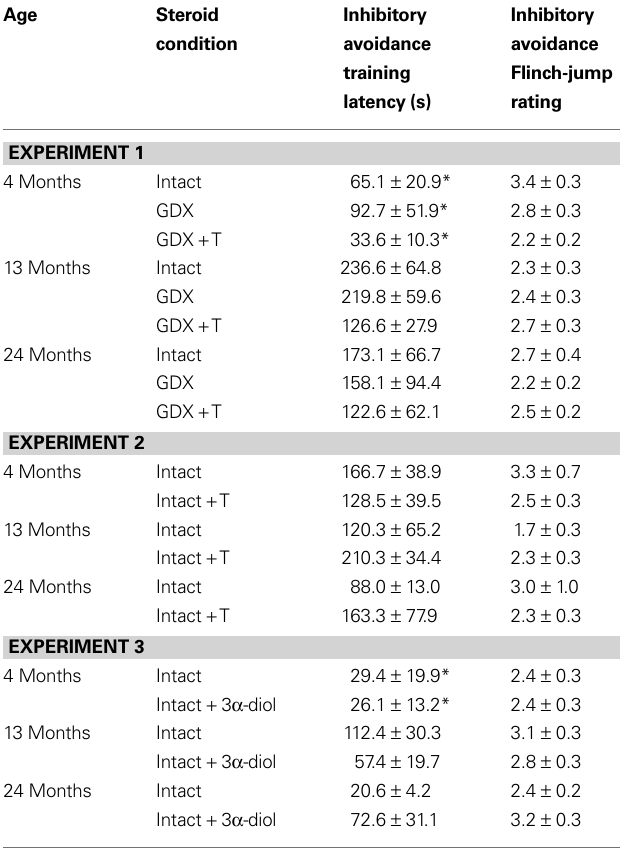
24-month-old gonadally-intact (intact), gonadectomized (GDX), or GDX and T-replaced (GDX + T; Experiment 1), intact and T-administered (Experiment 2), and intact or intact or intact and 3 α -diol-administered (Experiment 3) rats. Measures are: latency to shock-associated side during training in the inhibitory avoidance task (mean ± SEM), and fl inch-jump ratings (mean ± SEM) in response to footshock during training in this